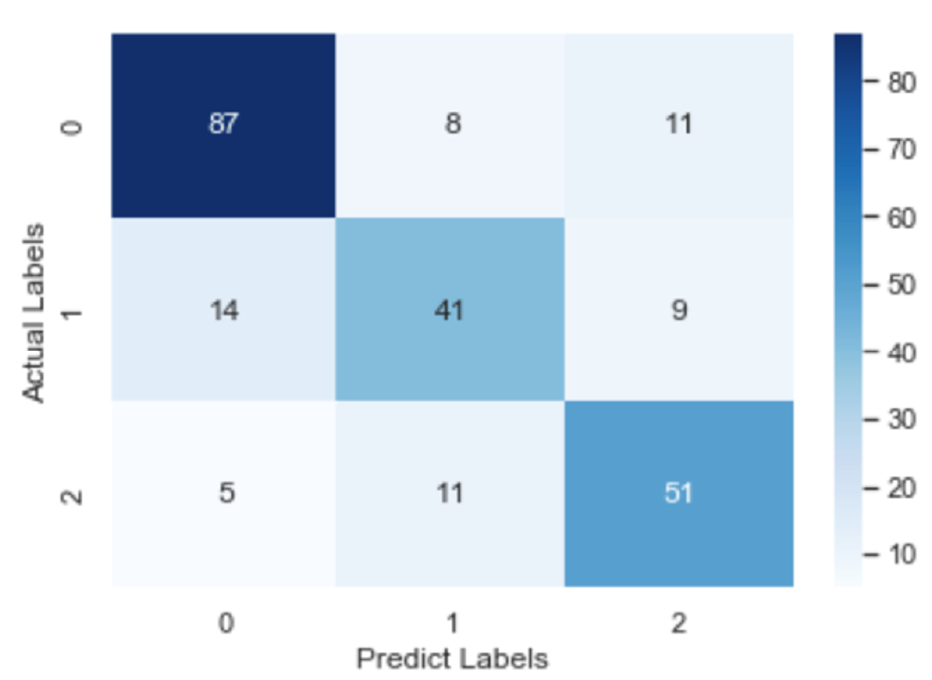
Figure 10. Confusion matrix of the fastText model.